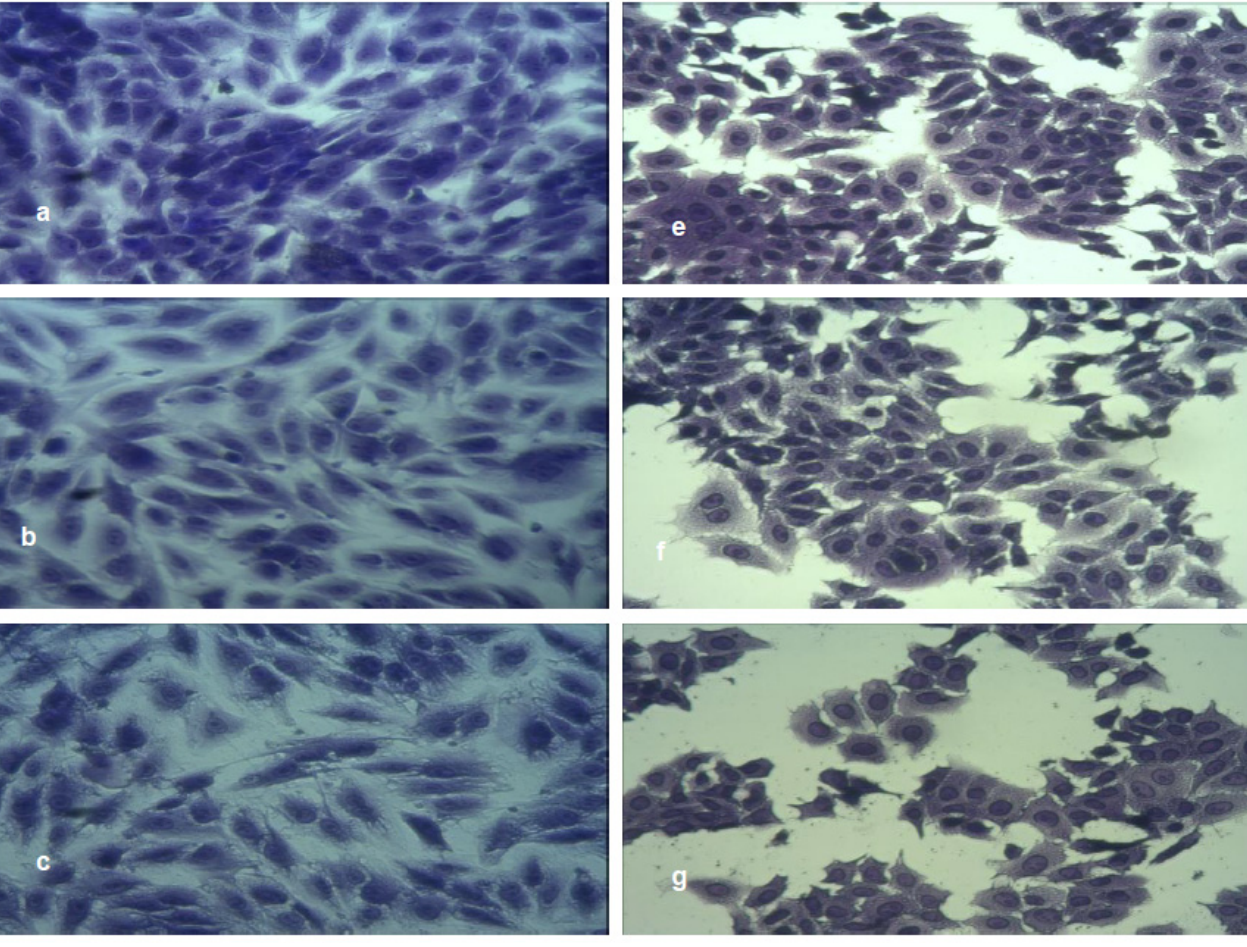
Figure 12. Cell morphology of MDCK II and A549 cell line on RGO and metal–RGO composites: ( a ) control MDCK II cells, ( b ) RGO, ( c ) Cu–RGO, ( d ) Ag–RGO; ( e ) control A549 cells, ( f ) RGO, ( g ) Cu–RGO, ( h ) Ag–RGO. Magnification 200×. A549 cells exhibit a quick response to the treatment expressed by disturbance of cell–cell contacts and reduction in the cell number. Moreover, the cells forming smaller groups become more rounded. The response of MDCK II cells upon treatment with pure RGO and with both nanocomposites is less pronounced due to the desmosomal cell contacts. The different